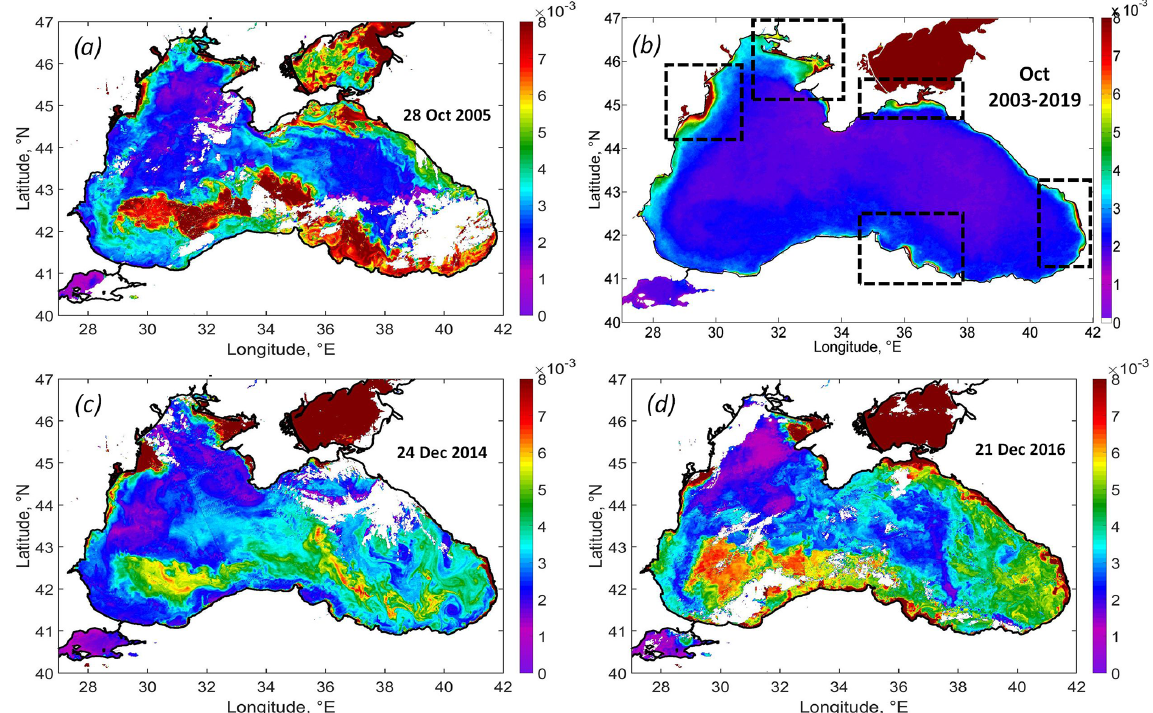
Figure 6. (a) MODIS R rs map on 28 October 2005, showing the intense coccolithophore bloom developed after the action of the QTC. (b) Climatic R rs map for October 2003–2019 (black rectangles show the main sources of the lithogenous articles in the Black Sea), similar to the case of the October 2005 coccolithophore blooms observed in the maps of R rs on 24 December 2014 (c) and 21 December 2016 (d)